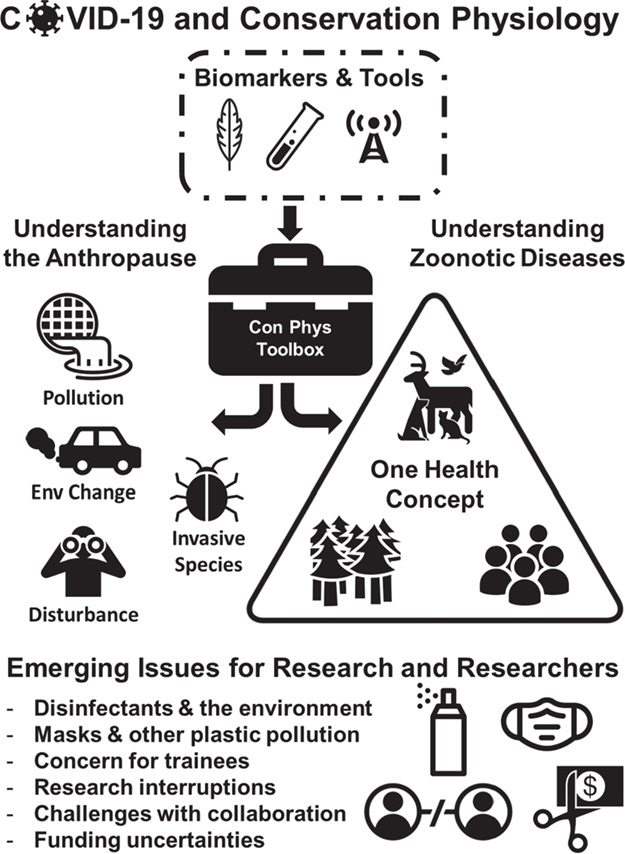
Infographic visualizing aspects of COVID-19 and conservation physiology. The conservation physiology toolbox includes various physiological biomarkers (e.g. glucocorticoids in feathers, oxidative stress indicators in blood) and electronic tag sensors to assess organismal responses to different challenges. The Anthropause has led to changes in pollution, environmental change, human disturbance and invasive species introductions and control, which can all be studied using the conservation physiology toolbox. Moreover, the toolbox can be used to study how human activities influence the environment, thus creating conditions in animals that favour emergence of zoonoses. COVID-19 has also created emerging issues that require conservation physiology research (e.g. effects of disinfectants and plastic medical waste on biodiversity), while at the same time impacting the conservation physiology research community.